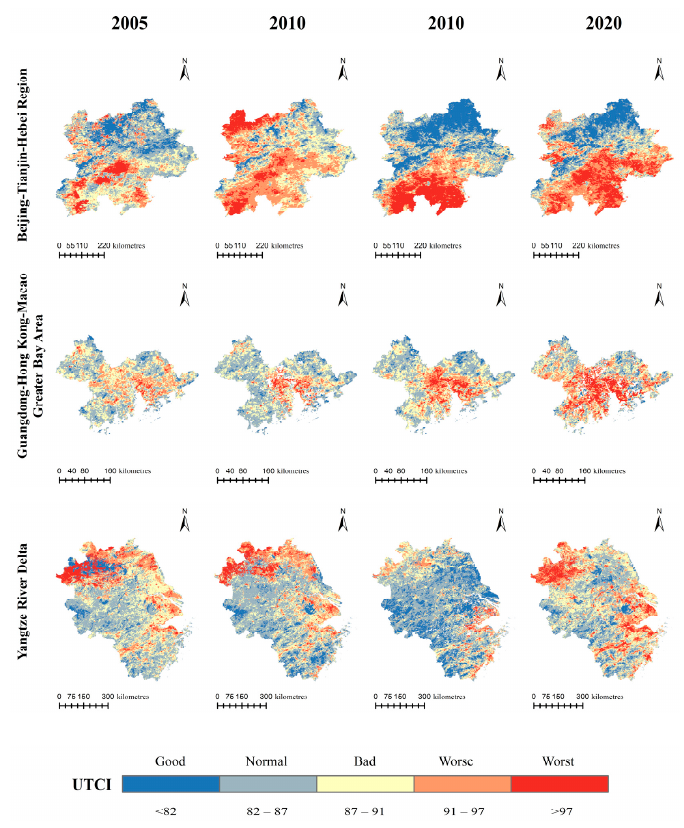
Figure 5. Spatiotemporal dynamics of UTCI in study areas in 2005–2020.